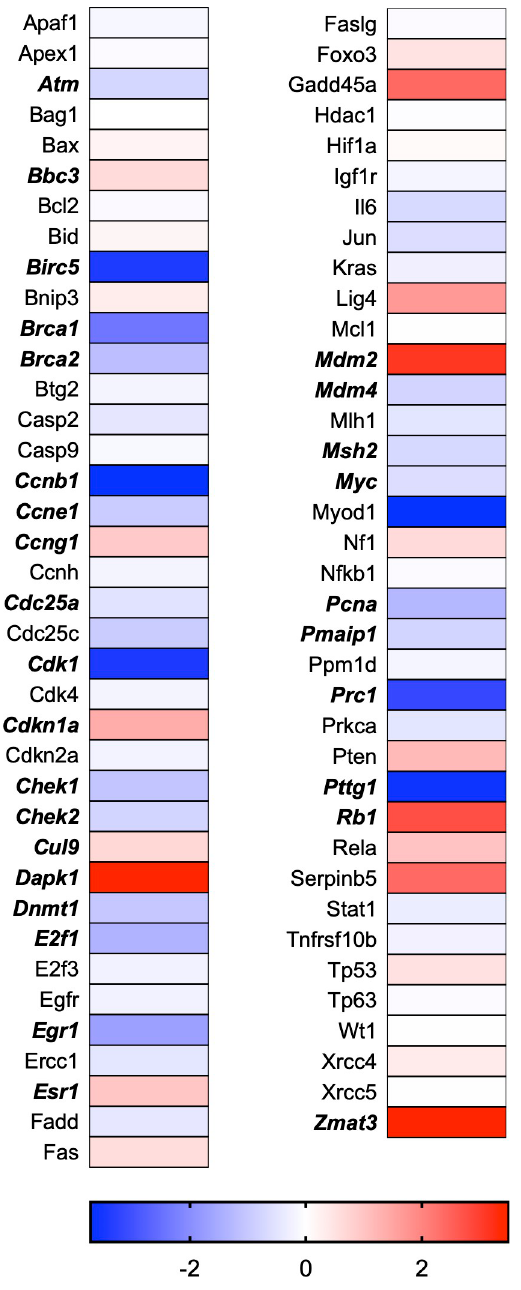
Fig 6. p53 signaling heat map. Bold text indicates significantly altered gene